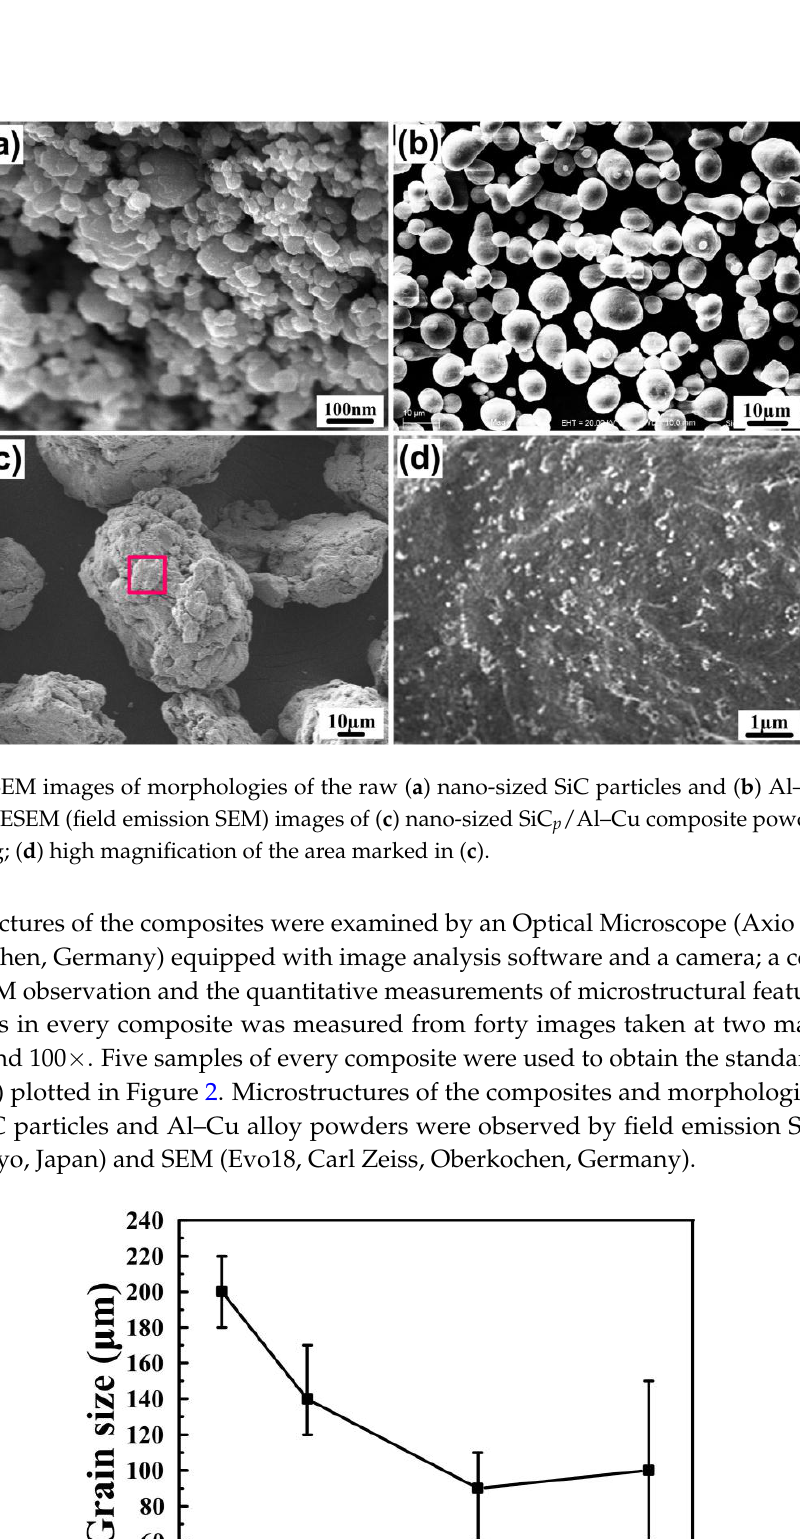
Figure 3. Cast microstructures of the nano-sized Al–Cu alloy and SiC p /Al–Cu composites with different SiC p contents; ( a ) Al–Cu alloy; ( b ) 1 wt. % SiC p ; ( c ) 3 wt. % SiC p ; ( d ) 5 wt. % SiC p . Figure 4 shows the engineering stress–strain curves of the cast Al–Cu alloy and nano-sized SiC p /Al–Cu composites, and Table 1 lists the detailed data of the tensile properties. As indicated, the